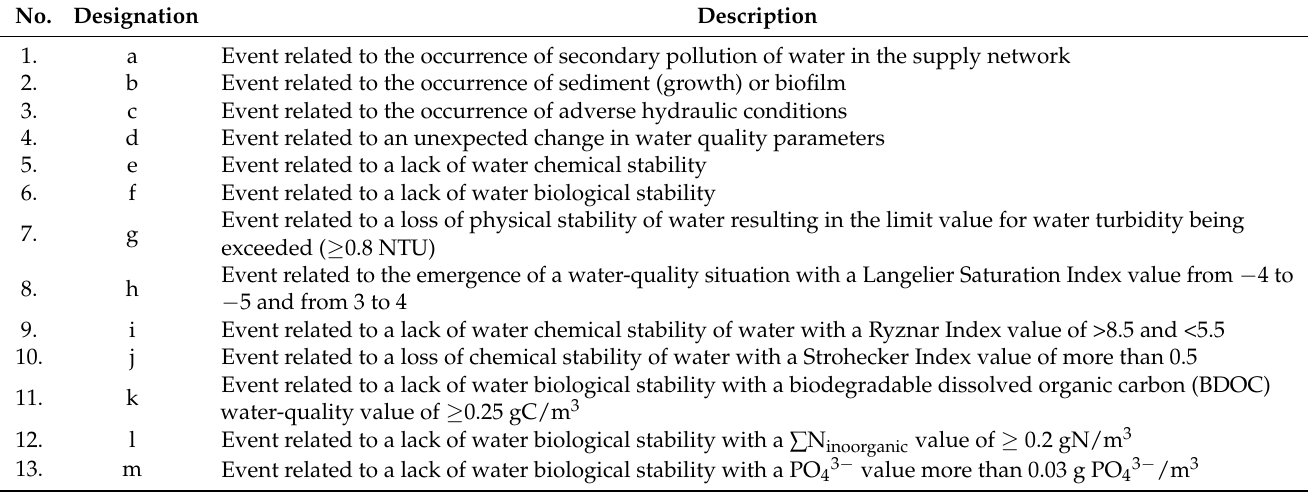
Table 1. Specific designations of the fault tree.